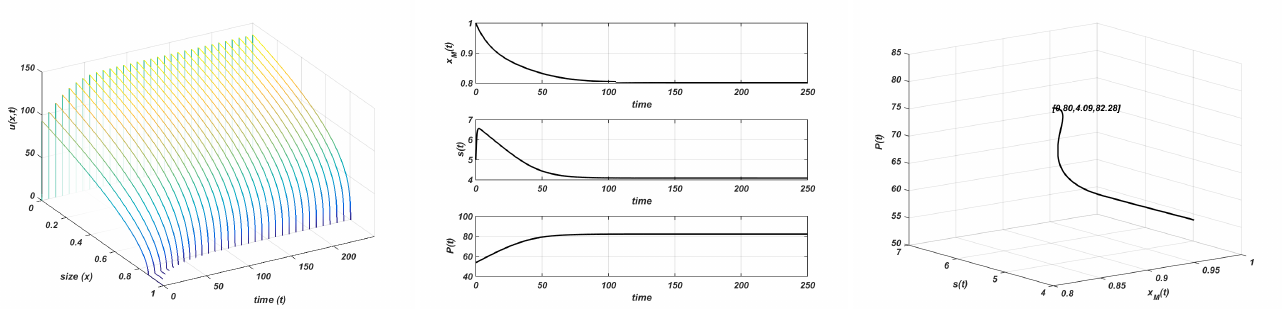
Figure 7. Gompertz growth. r = 3 and K = 10. Stable equilibria. Plot on the left : evolution of the structure of the consumer; plot in the centre : evolution of the maximum size, resource, and total consumer population to the equilibrium; plot on the right : orbit followed towards the equilibrium ( 0.80,4.09,82.28 )